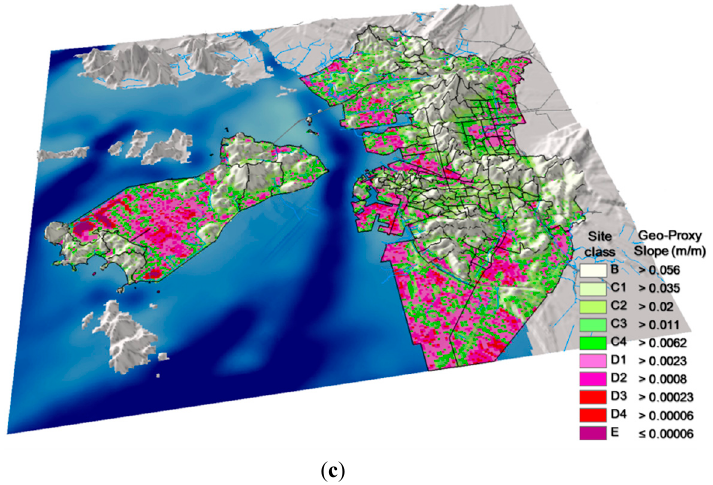
Figure 11. 3D view of spatial distribution of seismic site classes in Incheon based on the proposed geo-proxy parameters: ( a ) elevation (proposed criterion); ( b ) slope [15]; ( c ) slope (proposed criterion).